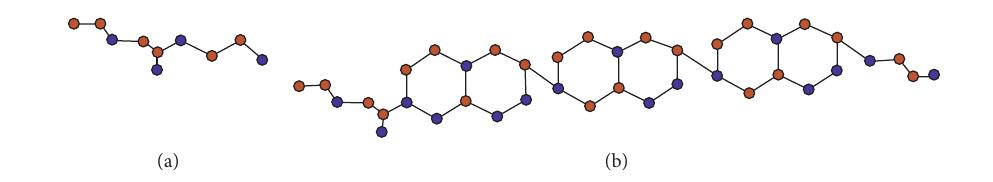
Figure 3: The unit cell and Si